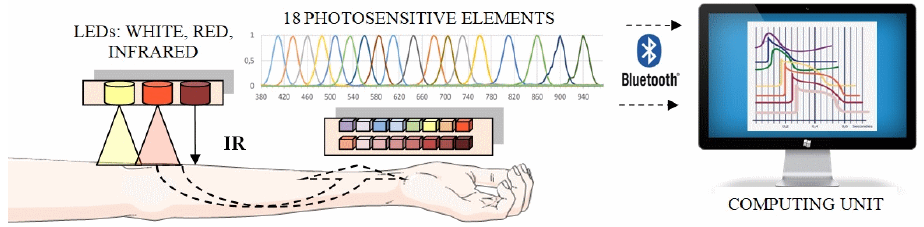
Figure 4. Structural diagram of a laboratory model of a hardware–software complex for analyzing the oxygen status of human tissues.